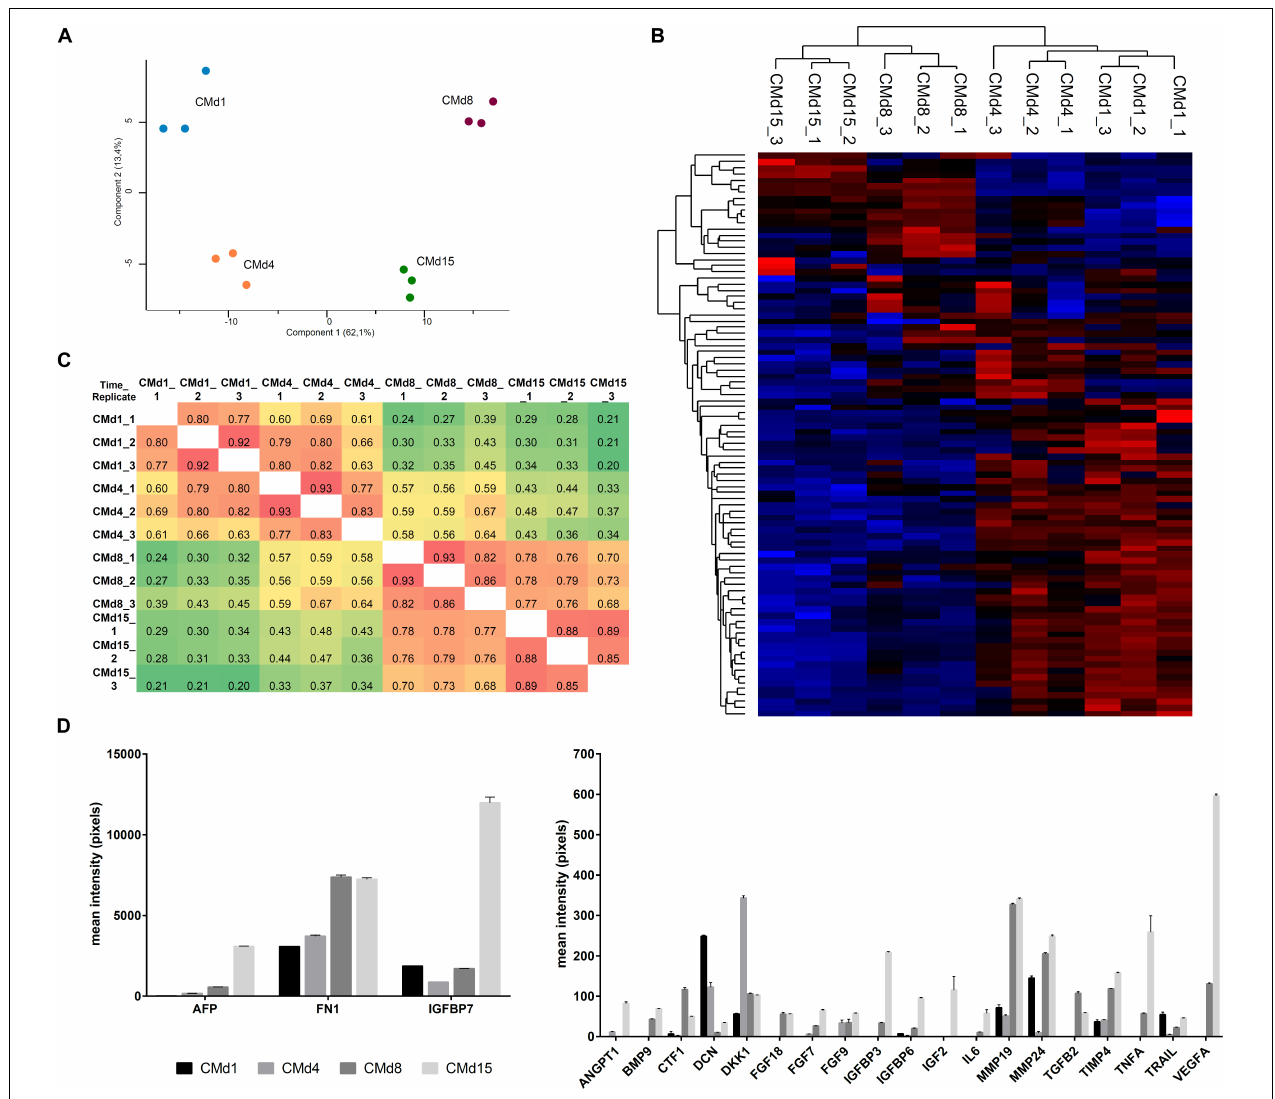
FIGURE 2 | Characterization of CM obtained during cardiac differentiation of hESCs by mass spectrometry and antibody array. (A) Principal component analysis of CM replicates obtained at four time points of differentiation. (B) Heatmap of the hierarchical clustering of CM samples. High z -scores and low z -scores are represented in red and blue, respectively. (C) Pearson’s correlation comparing all the replicates with each other (higher correlation in red and lower correlation in green). (D) Graphs representing the intensity of proteins identified at CMs using an antibody